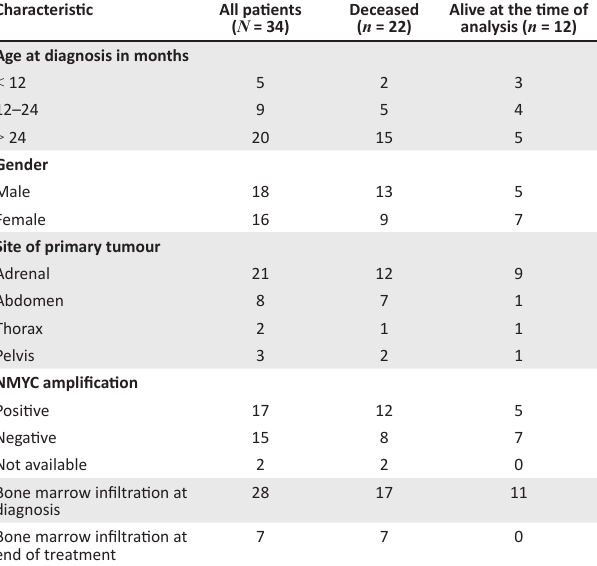
TABLE 1: Clinical and pathological characteristics of all neuroblastoma